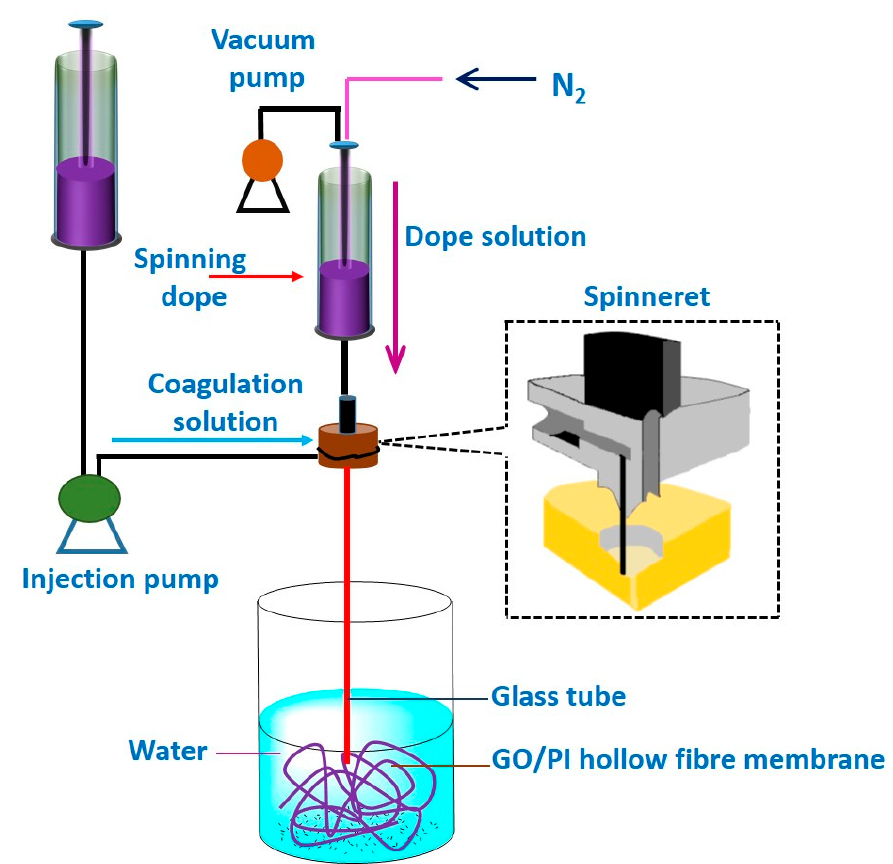
Figure 11. Schematic diagram of preparation of GO/PI hollow fiber membranes by direct spinning of a GO/PI suspension via phase inversion in water/NMP solution.